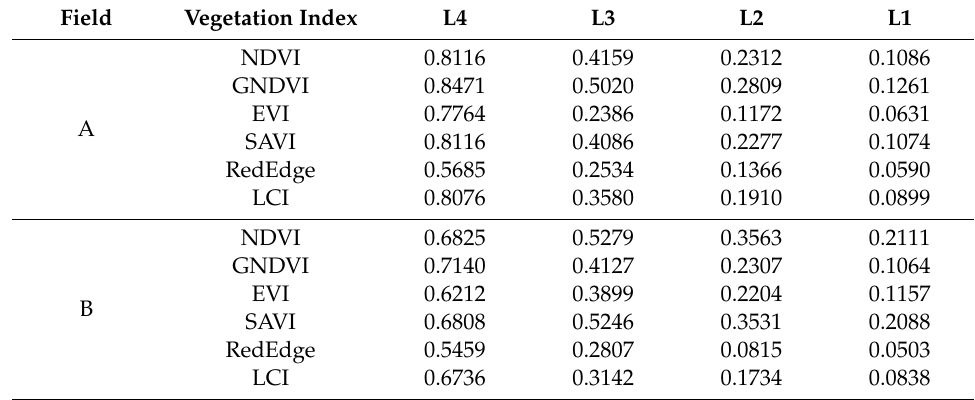
Table 6. Spectral angel di ff erences between the healthy cotton plant spectrum and the average infected plant spectra of di ff erent severity levels of cotton root rot in two experimental fields.